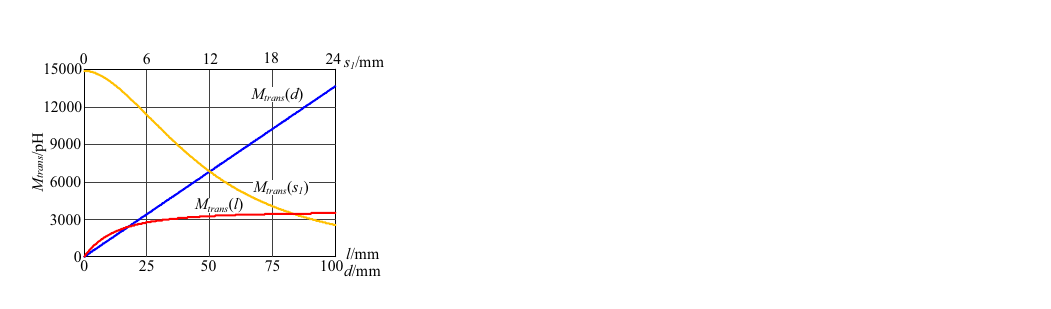
Figure 13. Calculation results of mutual inductance M trans varies with plug structure